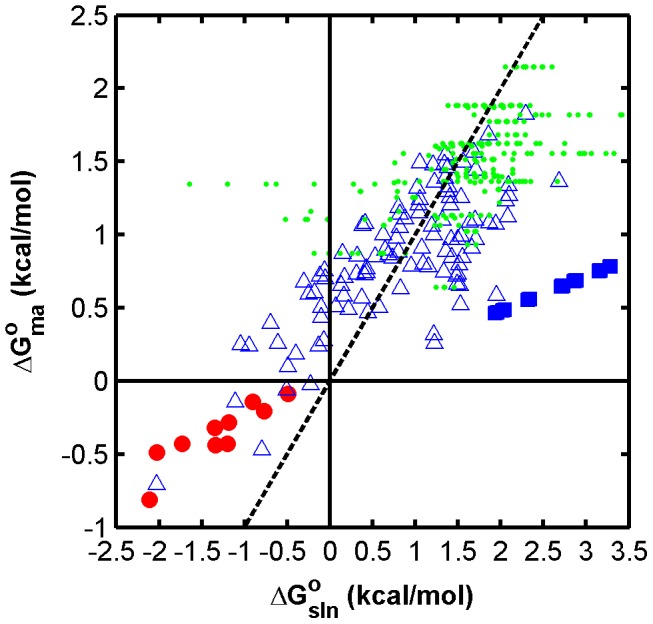
Relationship between in-solution and microarray free energy values (at 42°C).Red circles, nearest neighbors; blue triangles, single mismatch loops; blue squares, single bulged mismatch loops; green dots, tandem mismatch loops.